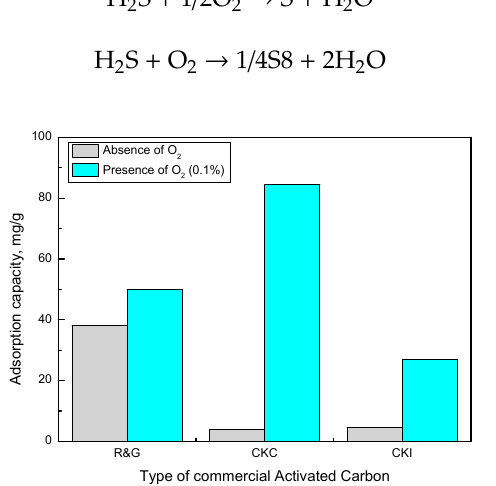
Figure 4. Adsorption capacities of the selected materials before and after 0.1% oxygen addition (adopted from [72]).